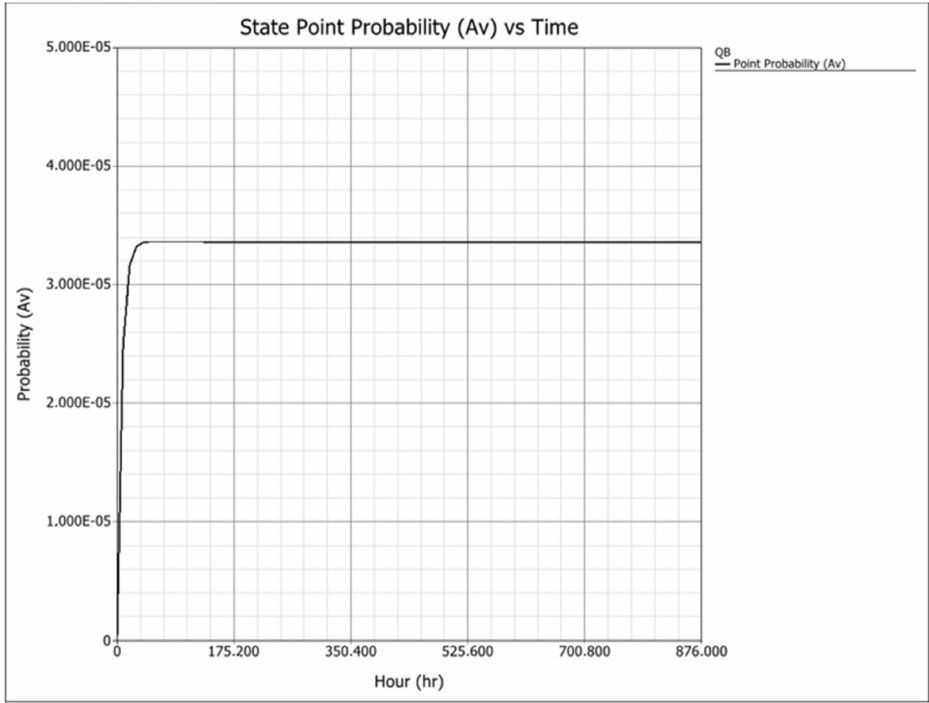
Figure 17. Probability of a focused FAS staying in the state Q B —failure (unreliability) for the state S 0 —B—type open line system, without notifying the PSP, as a function of time (study based on computational data from the BlockSim